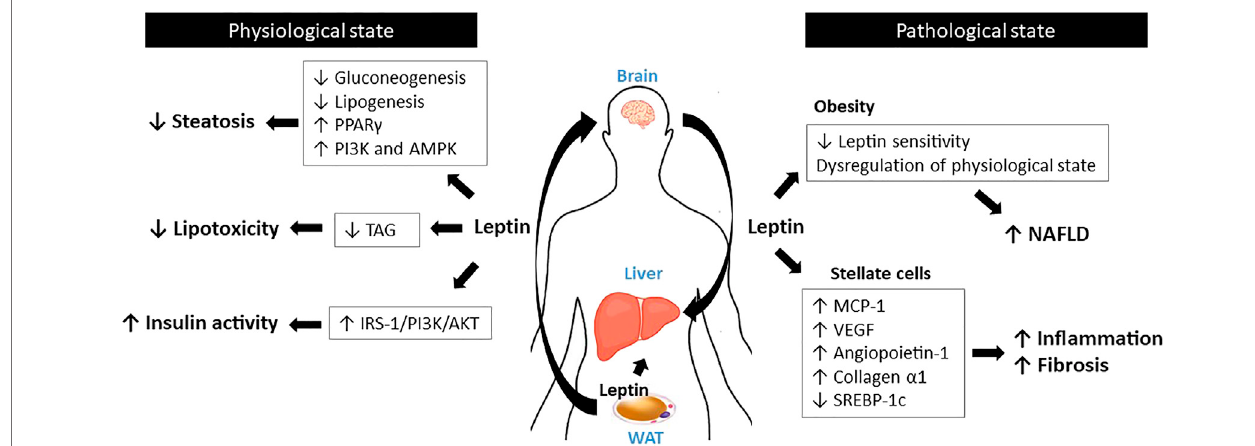
FIGURE 3 | Schematic diagram for the roles of leptin in the liver.